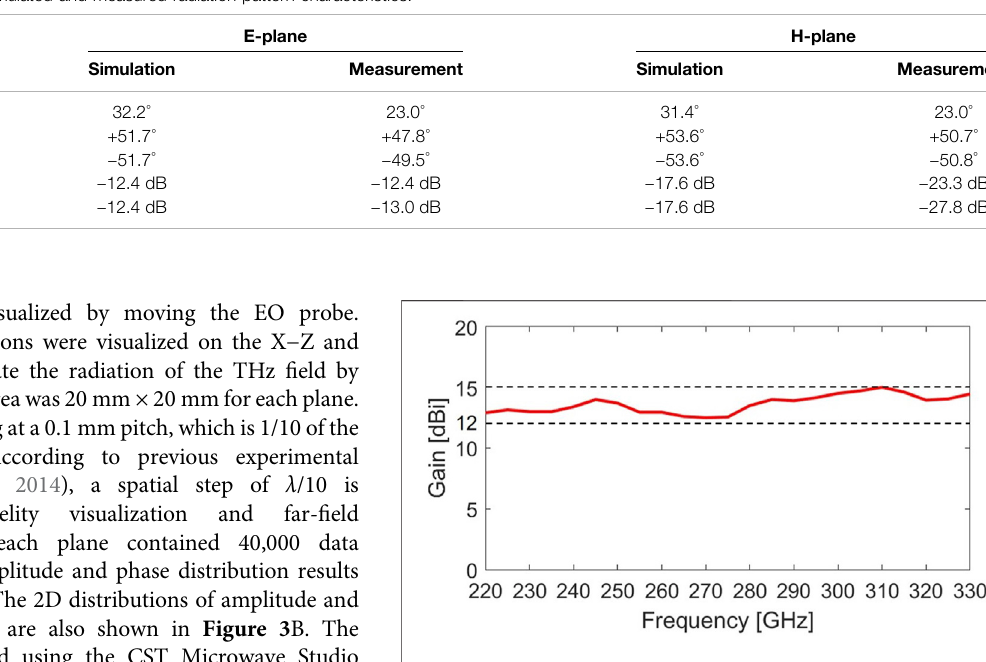
TABLE 1 | Comparison of the simulated and measured radiation pattern characteristics.